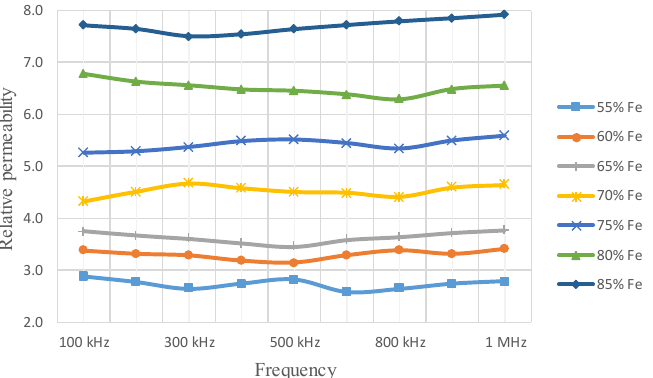
Figure 10. Relative permeability of cores made with different percentages of iron powder in the switching frequency range from 100 kHz to 1 MHz.